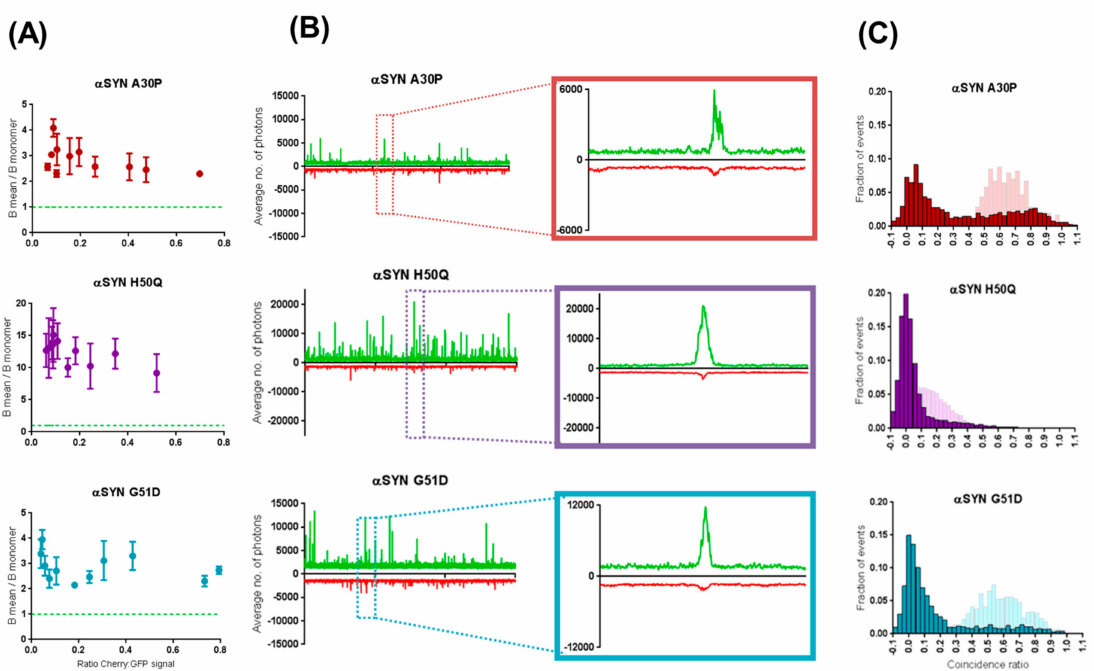
Figure 5. Individual expression of proteins prior to mixing irrevocably reveals a model of selective incorporation of β S into specific α S’s aggregated species. ( A ) Brightness analysis averaged plots were acquired for three independent measurements of triplicated 30 s fluorescent time traces using a stationary microscope plate setup. Error bars represent the SE of those 3 independent measurements Here mutants A30P, H50Q and G51D are shown for final β SWT(Cherry): α S(GFP) ratios < 0.8. Brightness values are normalized against the brightness of the GFP monomer (green dashed line). ( B ) 90-s fluorescent time traces were acquired by scanning confocal microscopy and ( C ) two-color coincidence was applied to a population of >400 fluorescent bursts. Coincidence histograms (dark colour) were compared with the ones obtained from coexpression of the same proteins